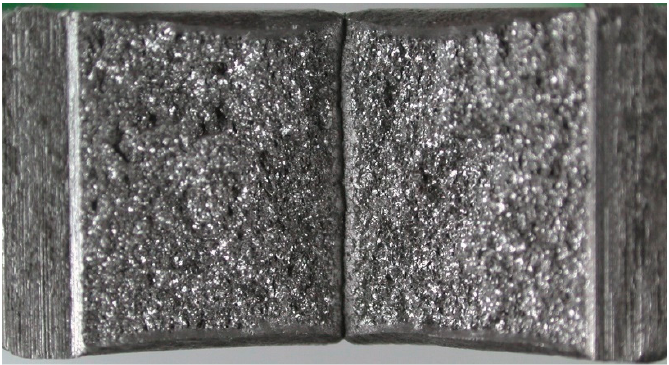
Figure 16. Fracture surfaces of GCH_D0_01_after the Charpy impact test (with a twice as long temperature cycle).